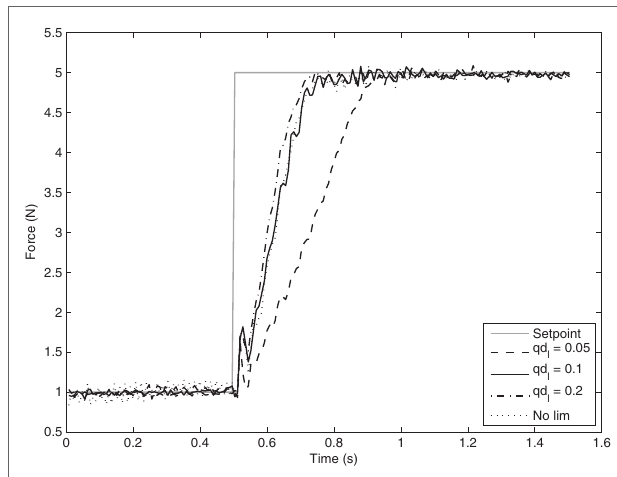
FigUre 9 | Force response in the z-direction when joint velocities are limited. qd l is the limitation applied to all joint velocities in rad/s. K is set to 0.005 and K I to